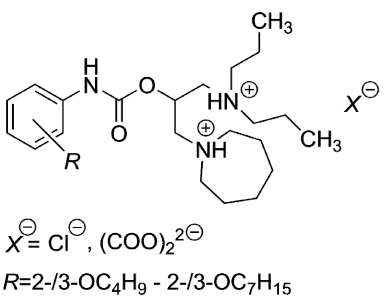
Figure 3. Dibasic esters of R -substituted phenylcarbamic acid previously inspected in